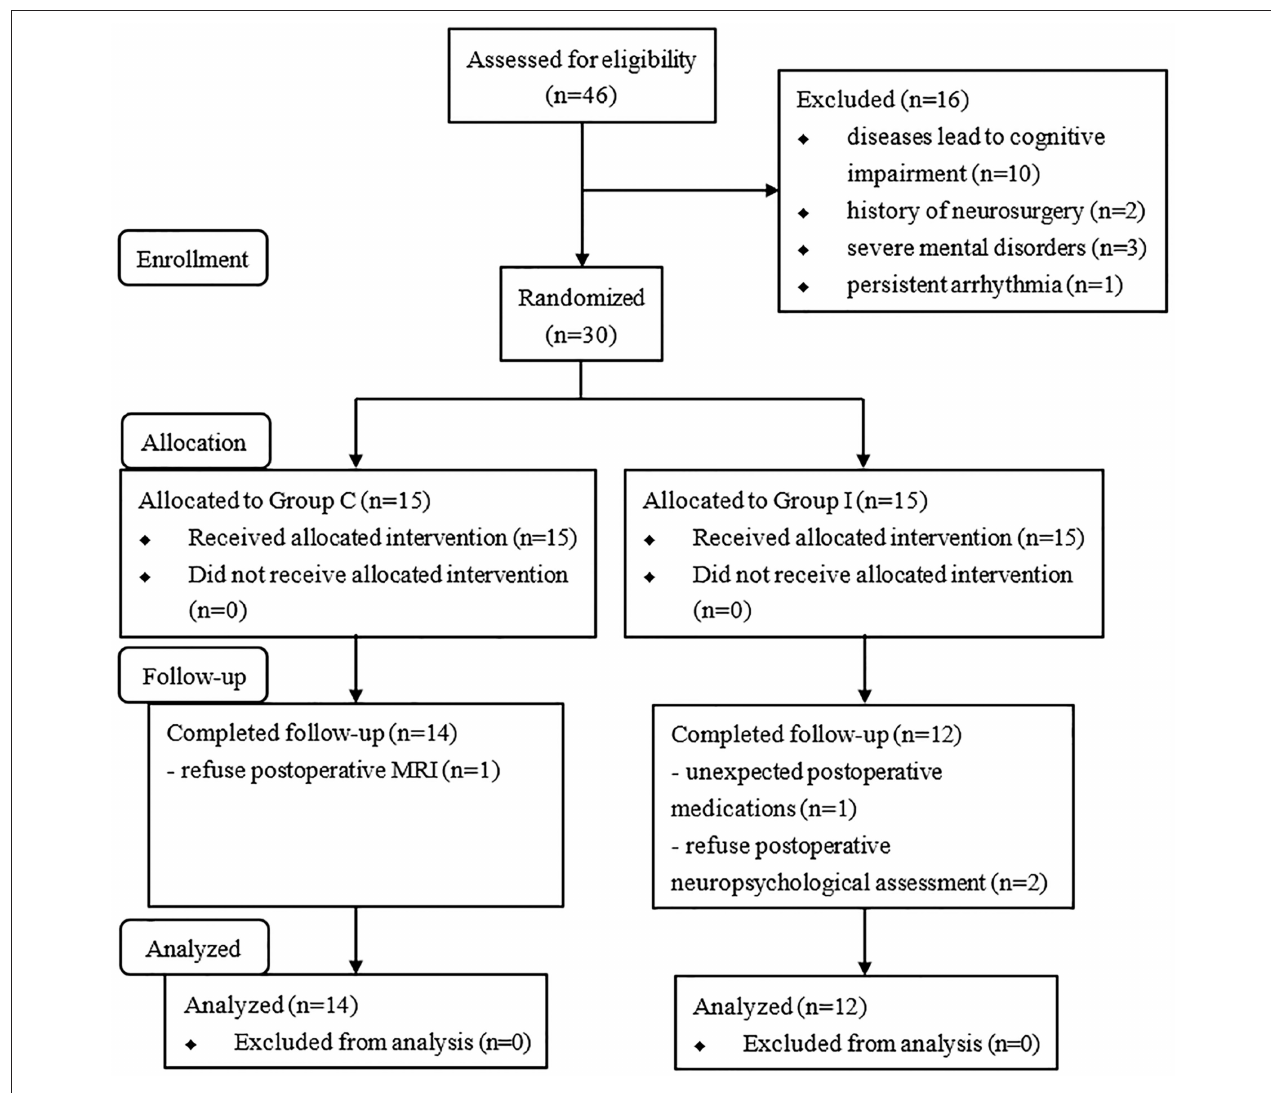
FIGURE 2 | Flowchart of the study.